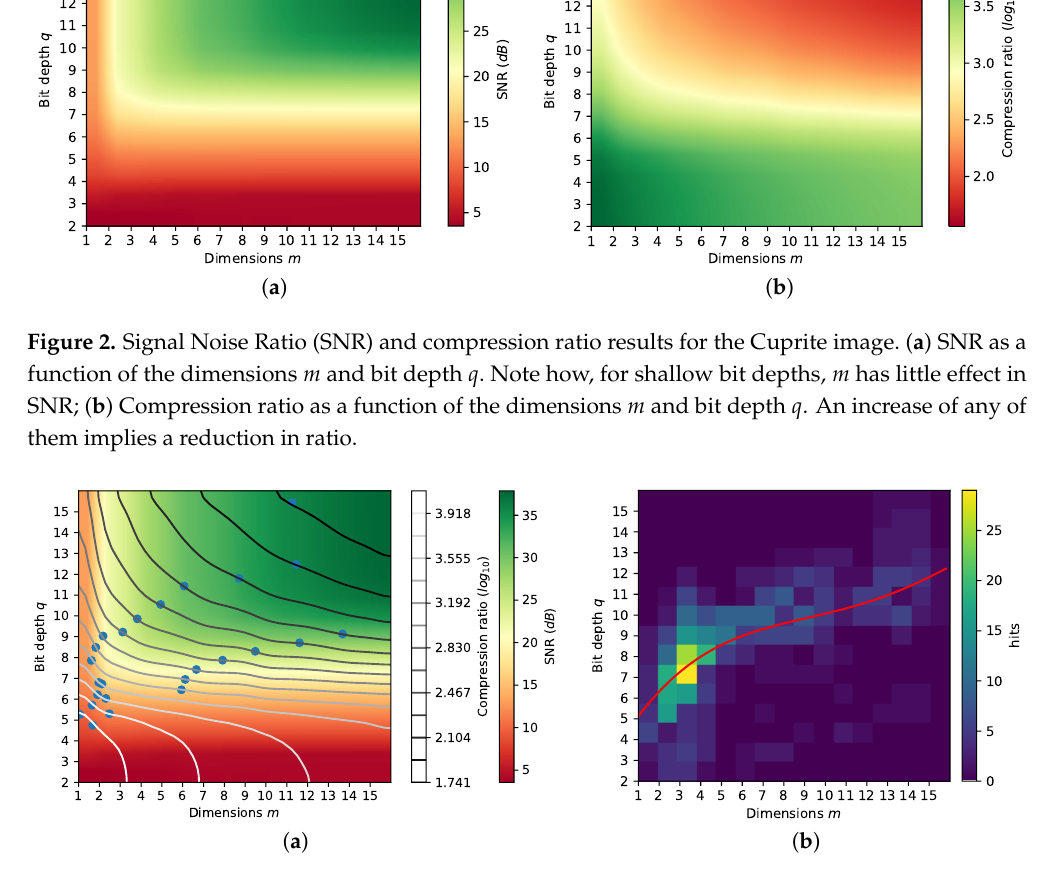
Figure 3. Optimal results for ( a ) the REN image and ( b ) the aggregate of all images. ( a ) Finding out the optimal points where SNR is maximized for a given compression ratio. (Note: not all 50 lines are shown for viewing clarity.); ( b ) Regression showing where the distortion-ratio performance is maximized. Each hit represents an optimal configuration for some